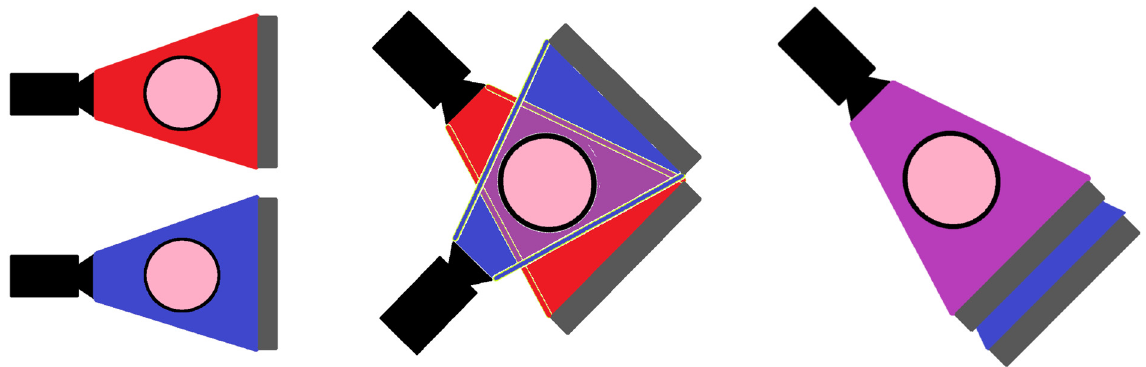
Figure 2. Current dual-energy approaches can be broadly classified into three categories. In all figures, the object being imaged is the pink circle, the X-ray source is in black, the detector is in grey, the high-energy X-ray beam is shown in blue, and the low-energy beam is shown in red. (LEFT) Voltage-switching approaches involve imaging the object twice for each projection angle, once at a lower tube voltage and once at a higher tube voltage. This switching can be performed rapidly so that the resulting images are temporally offset, but spatially approximately coincident. (MIDDLE) Dual-source approaches involve the simultaneous acquisition of the images using two different X-ray beam-detector pairs. The acquired images are thus temporally synced but spatially offset. (RIGHT) Dual-detector approaches involve the use of multiple detectors behind each other. The X-ray beam is attenuated in an energy dependent way as it passes through the first detector such that a beam with a higher average energy spectrum is incident on the second detector. The resulting images are spatially and temporally coincident but show a higher correlation. Adapted with permission from ref. [32]. Copyright 2021 The Institute of Cancer